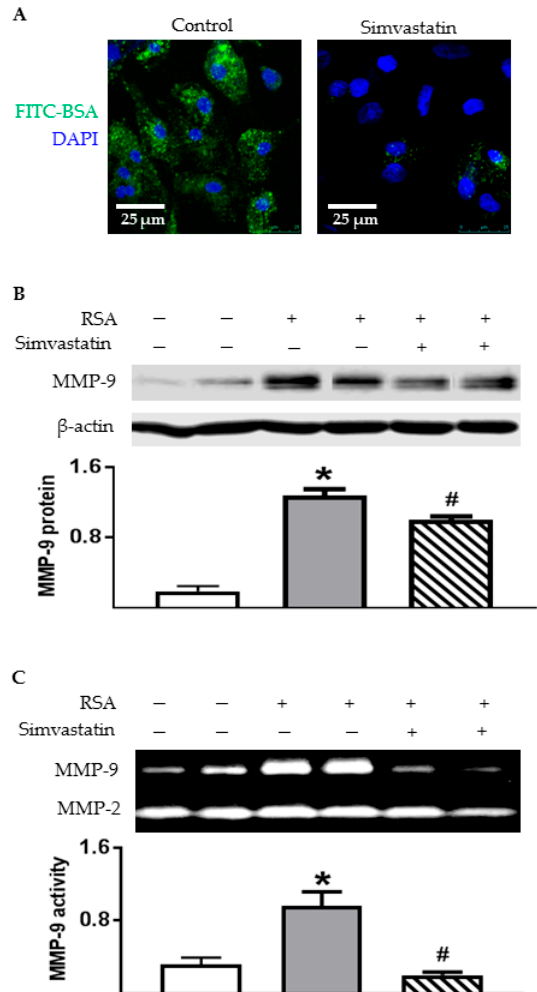
Figure 10. Albumin-induced MMP-9 production was attenuated by simvastatin treatment in primary rat TECs. ( A ) Representative confocal images show decreased FITC-BSA signal in simvastatin-treated TECs compared to DMSO vehicle controls; ( B ) Western blot analysis of MMP-9 protein in TECs treated with RSA (0.5 mg/mL) for 24 h in the absence or presence of simvastatin (10 µM); ( C ) Gelatin zymograph of MMP-2 and MMP-9 activities in the culture supernatants of TECs. Values are mean ± SEM, n = 4; * p < 0.05 vs. unstimulated normal control; # p < 0.05 vs. vehicle-pretreated albumin-stimulated cells.